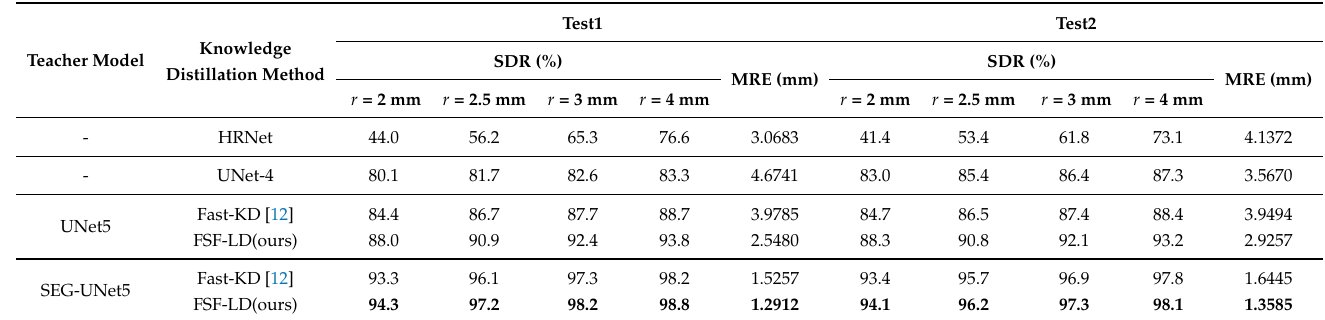
Table 4. 2D hand radiograph dataset: The comparison results for our proposed KD method on the 2D hand radiograph dataset. The student model is UNet4, while the teacher model is UNet5 and SEG-UNet5.